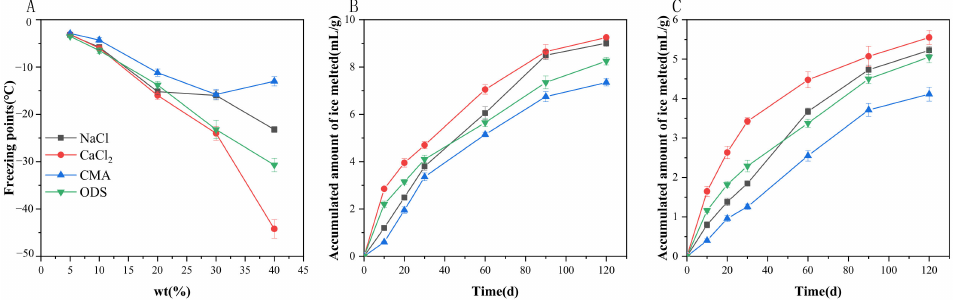
Figure 6. ( A ) Freezing point comparison of various deicing salts; accumulated amount of melted ice with deicing salts at ( B ) − 5 ◦ C and ( C ) − 15 ◦